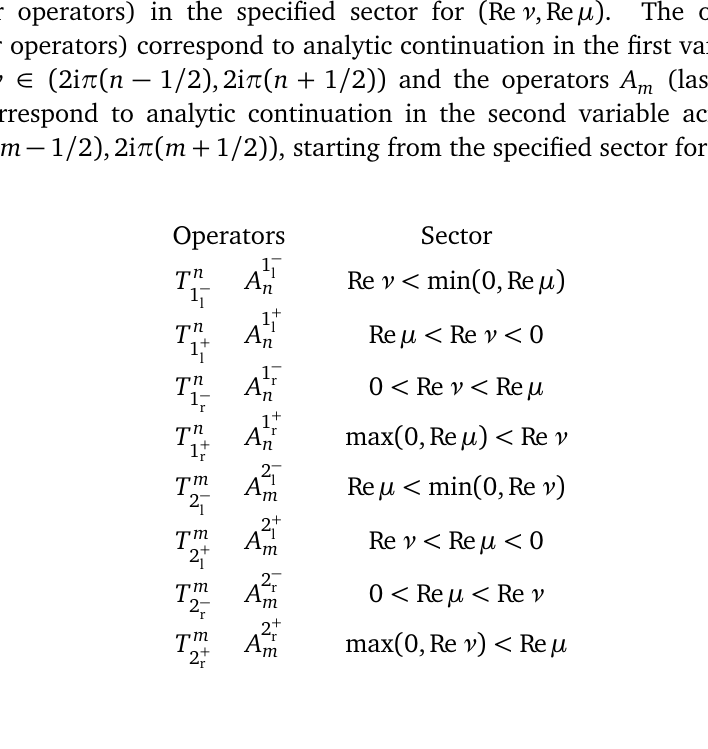
Table 1: Translation operators T n , T m and analytic continuation operators A A defined on functions f analytic in (cid:68) m